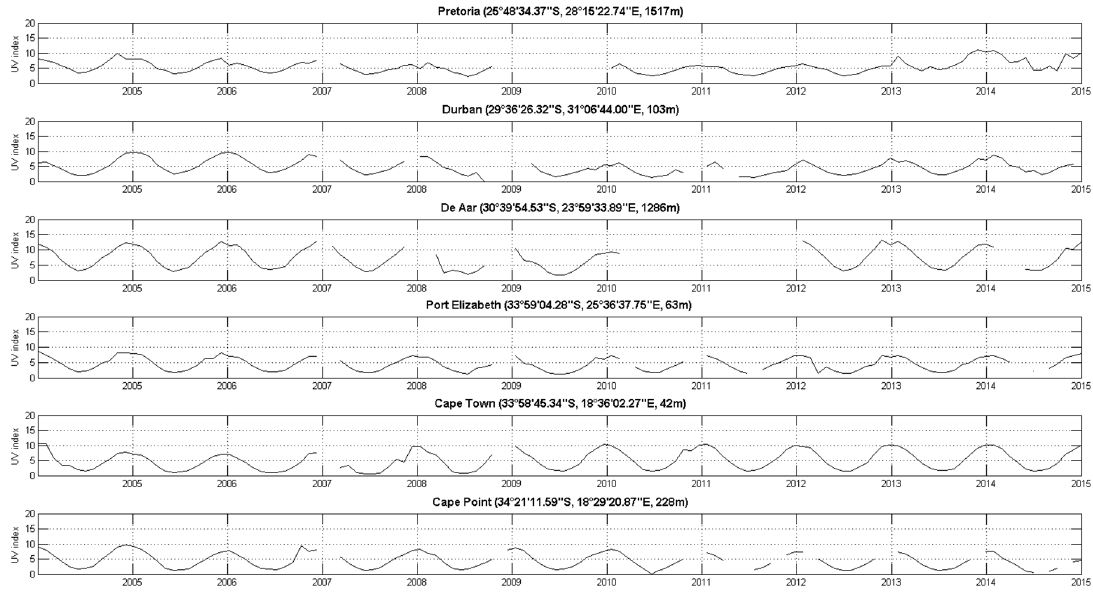
Figure 10. Ground-based monthly mean UV indices from 2004 to 2015 for the six South African Figure 10. Ground ‐ based monthly mean UV indices from 2004 to 2015 for the six South African sites.